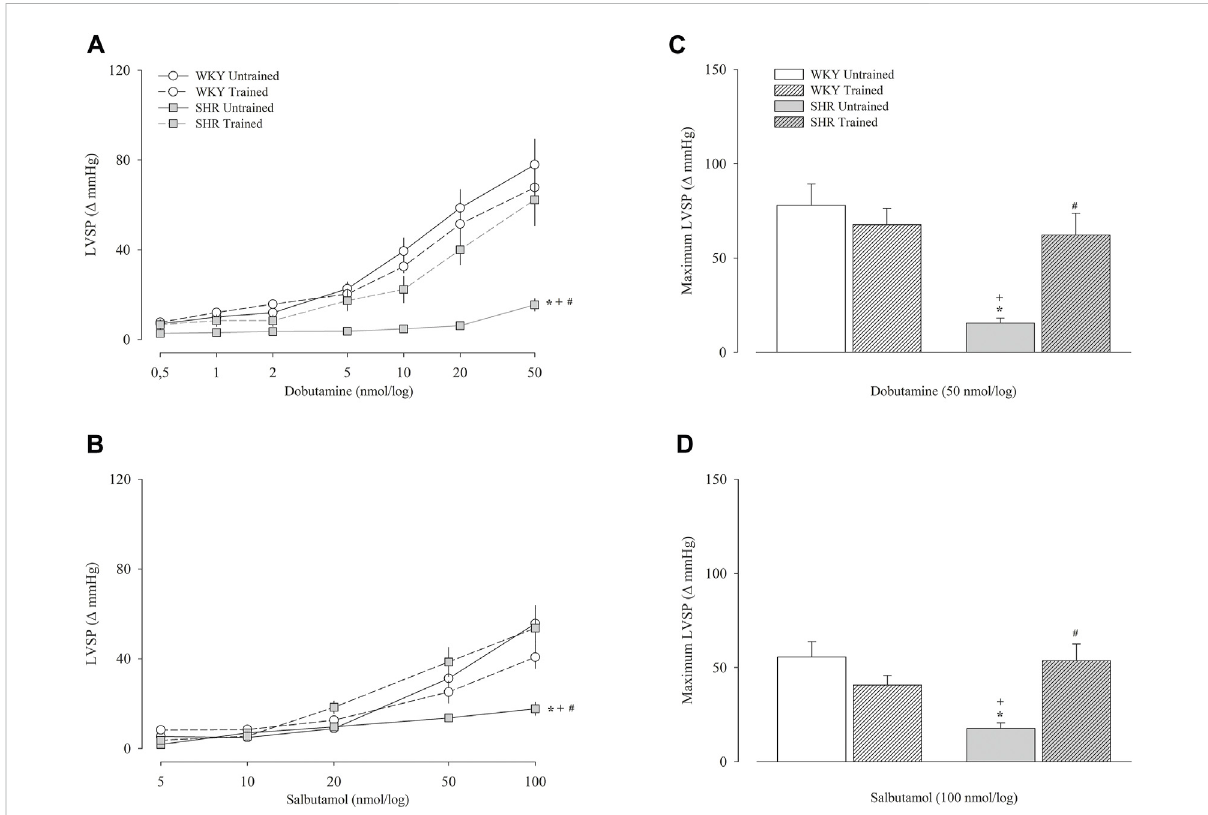
FIGURE 3 Left ventricular systolic pressure (LVSP) after administration of dobutamine (A) and salbutamol (B) in untrained ( N = 07) and trained ( N = 07) normotensiveWistarKyoto(WKY)andhypertensivespontaneouslyrats(SHR).Thegraphsontherightrepresentthemaximumresponseobtainedfor dobutamine(50 nmol) (C) andsalbutamol(100 nmol) (D) .Valuesareexpressedindelta( Δ ).mmHg,millimetersofmercury.Allvaluesarepresentedas themean±standard errorofthemean.* p < 0.05vs.WKY untrained group; + p < 0.05vs. WKYtrainedgroup; # p < 0.05vs.SHR untrained